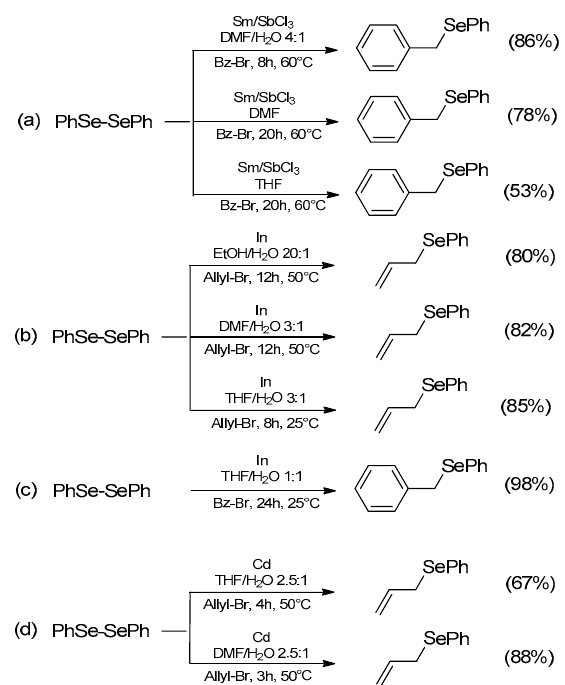
Figure 2. Nucleophilic selenenylation of benzyl and allyl bromides: ( a ) promoted by Sm/SbCl 3 ; ( b , c ) promoted by Indium; ( d ) promoted by Cadmium.